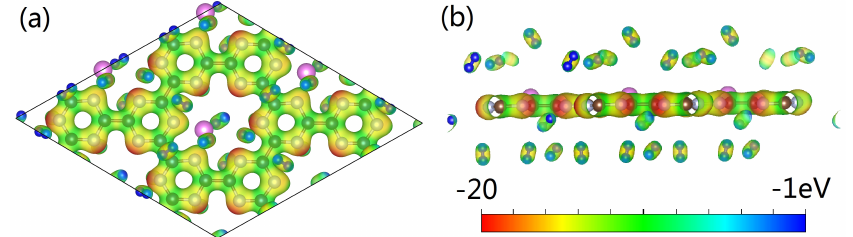
Figure 7. ( a , b ) The map of electrostatic potential distribution for the Al-doped g-CN with adsorbed H 2